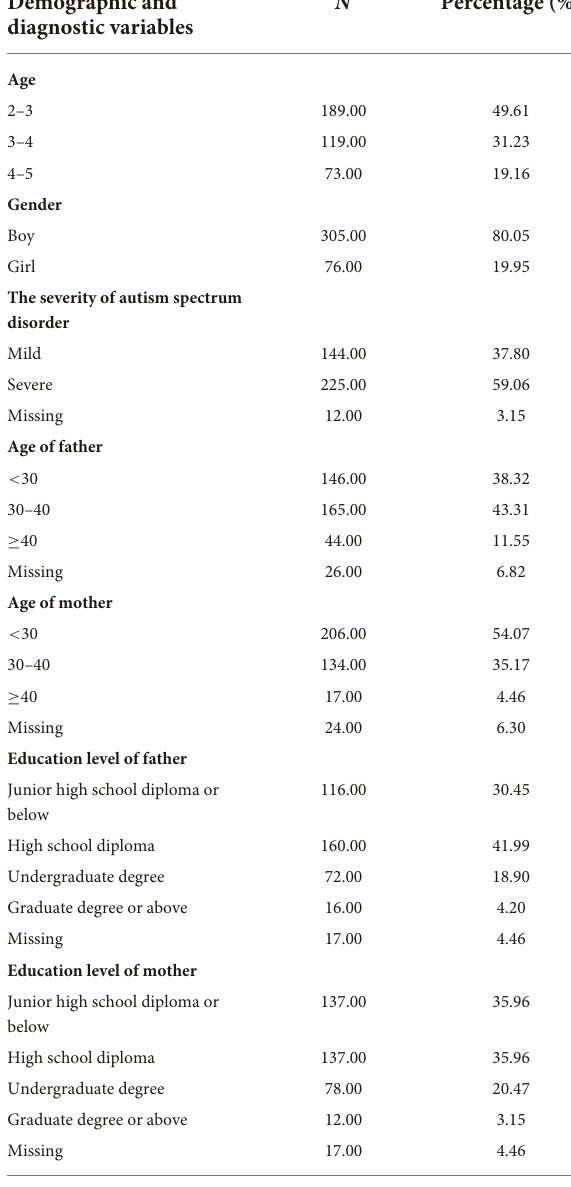
TABLE 1 Socio-demographic and diagnostic